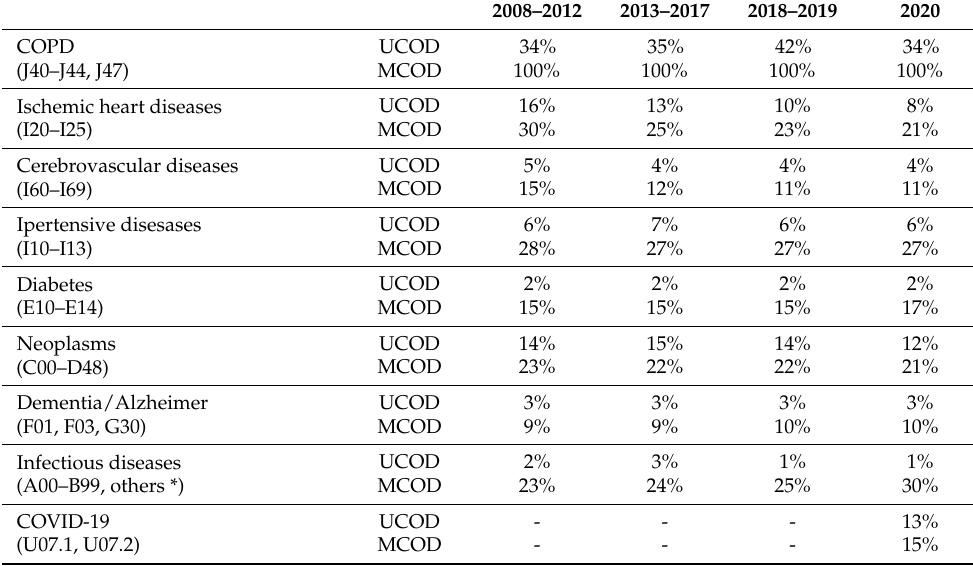
Table 2. COPD and common comorbidities/complications (ICD-10 codes) selected as the underlying cause or death (UCOD), or with any mention in death certificates (MCOD), out of all deaths COPD- related deaths. Residents aged ≥ 40 years, Veneto region (Italy), 2008–2020.